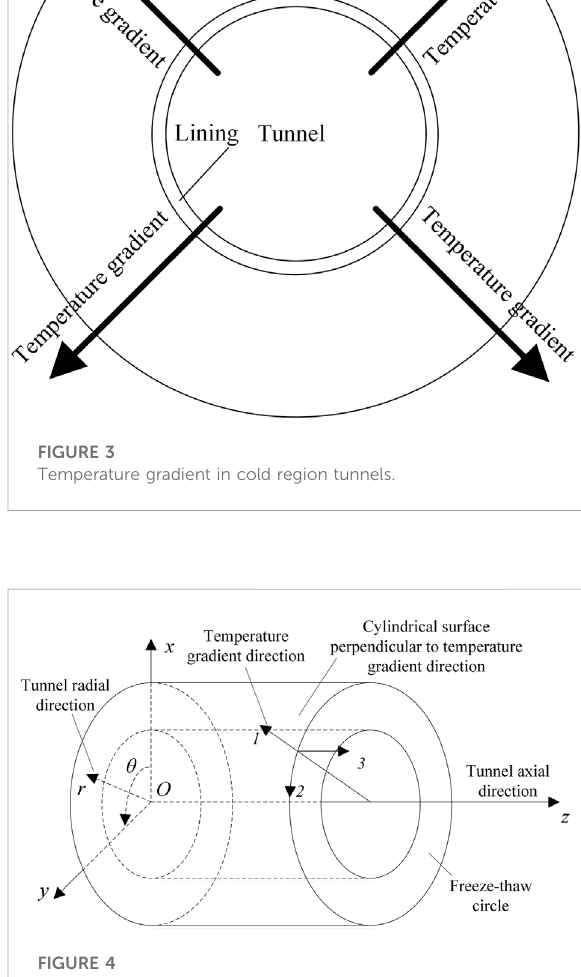
FIGURE 4 Transverse isotropy of freeze – thaw circle in cold region